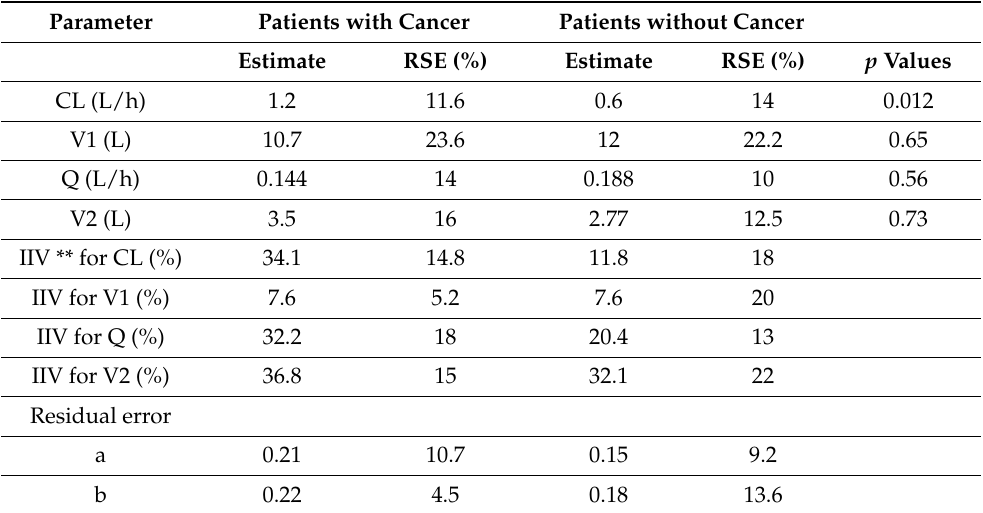
Figure 2. Predicted–corrected visual predictive check (pcVPC) (shaded areas) and observed data (circles) for micafungin concentration vs. time based on 1000 Monte Carlo simulations. Solid blue lines represent the 10th, 50th, and 90th percentiles of the observed data. Shaded regions represent 90% confidence interval around the 10th (Below blue shaded region), 50th (Middle pink shaded region), and 90th (Above blue shaded region) percentiles of the simulated data. Table 2. Population pharmacokinetic parameter estimates of micafungin following intravenous infusion.